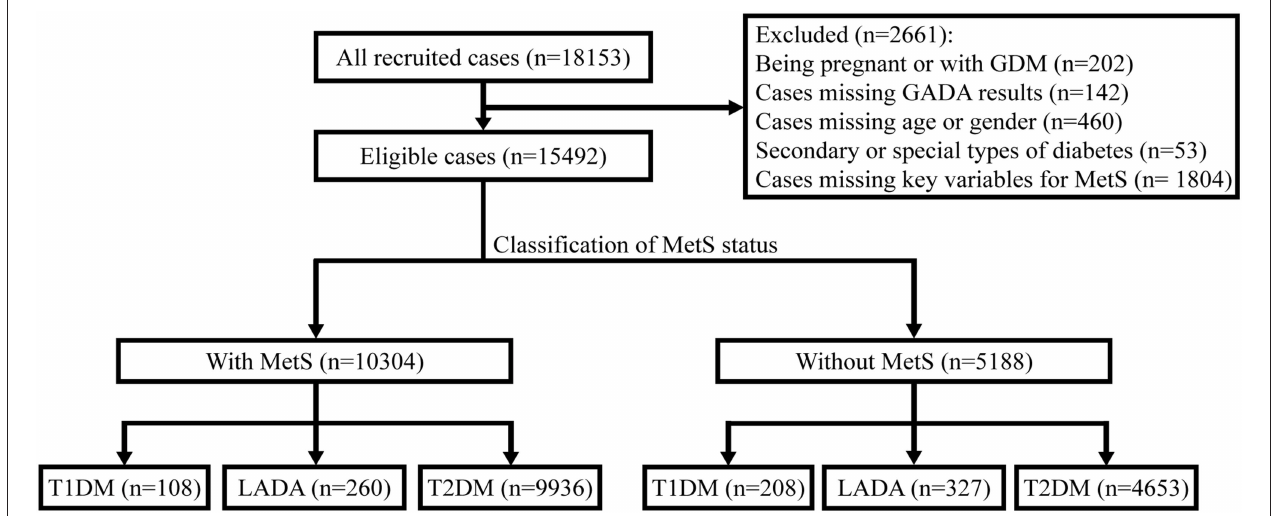
FIGURE 1 | Flow diagram and classification of 15,492 newly-diagnosed adult-onset patients with diabetes for MetS status in China. GDM, gestational diabetes mellitus; GADA, glutamic acid decarboxylase autoantibody; MetS, metabolic syndrome; T1DM, type 1 diabetes mellitus; T2DM, type 2 diabetes mellitus; LADA, latent autoimmune diabetes in